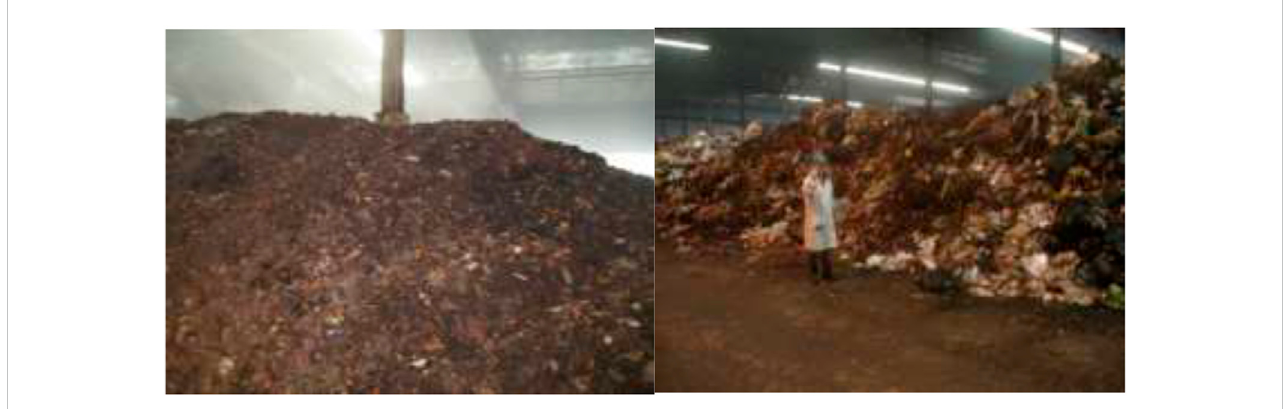
FIGURE 1 Composting windrow and sampling operation in the composting plant.